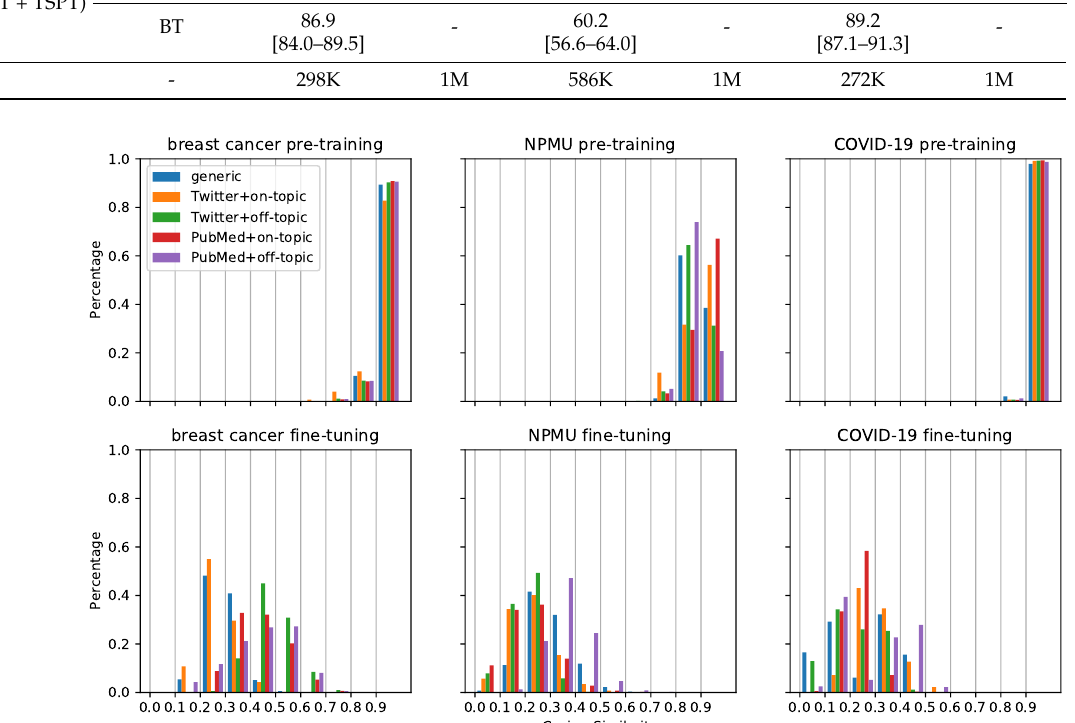
Figure 2. Histograms of the distributions of cosine similarities for the models initialized from RoBERTa_Base and pretrained on 298K, 586K, and 272K samples for the breast cancer, NPMU, and COVID-19 tasks,